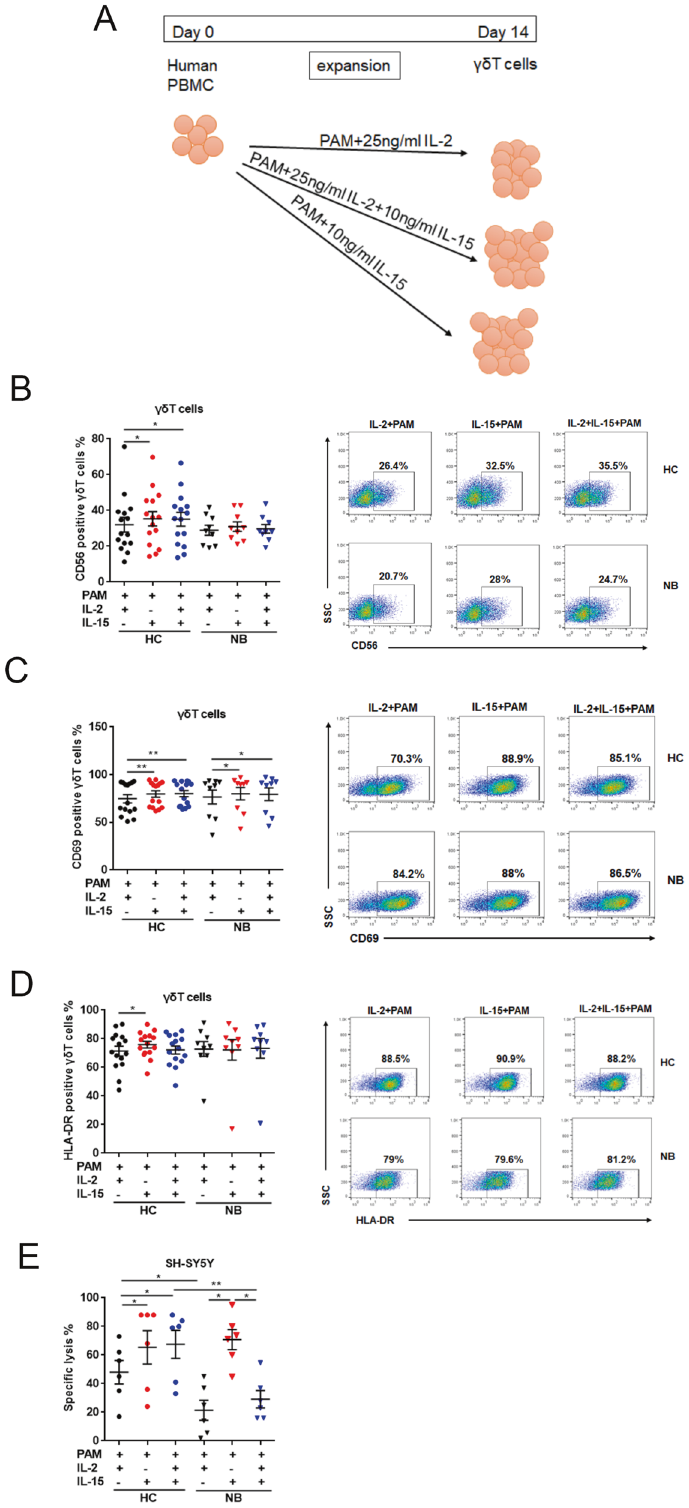
Fig. 5 Quali fi cation of γδ T-cell activated phenotype and cytolytic activity. A Flowchart of the experimental setup to study activated phenotype and cytolytic activity of IL-15-fostered γδ T cells. B – D The expression of activated markers including CD69, CD56, and HLA-DR in expanded γδ T cells was measured by fl ow cytometry at day 14 (HC, n = 15; NB, n = 9). Data were mean ± SEM from three independent experiments. Statistical analysis was performed using an unpaired t test. *, p < 0.05; **, p < 0.01. E The cytotoxic assays were performed and expanded γδ T cells were cultured with NB cell line SH-SY5Y at the ratio of 1:10 (HC, n = 6; NB, n = 6). Data were mean ± SEM from three independent experiments. Statistical analysis was performed using one-way ANOVA and Dunnett ’ s multiple comparisons. *, p < 0.05; **, p < 0.01.